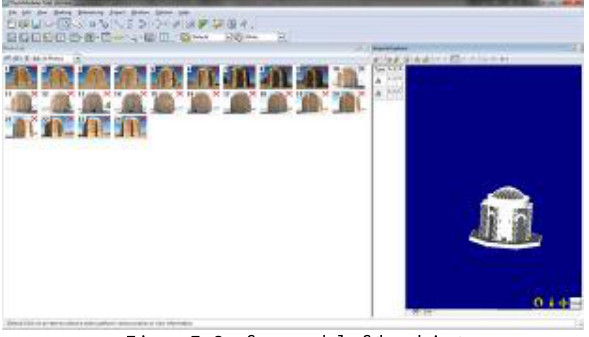
Figure 7. Surface model of the object